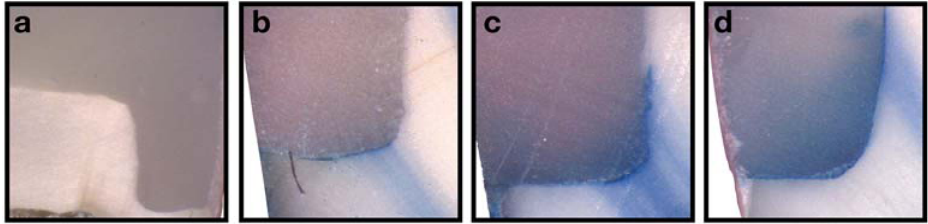
Figure 3. Representation of dye penetration at different scores ( × 8 and × 25). ( a ) Gingival score Table 2. Evaluation of microleakage scores according to groups. Coronal Microleakage